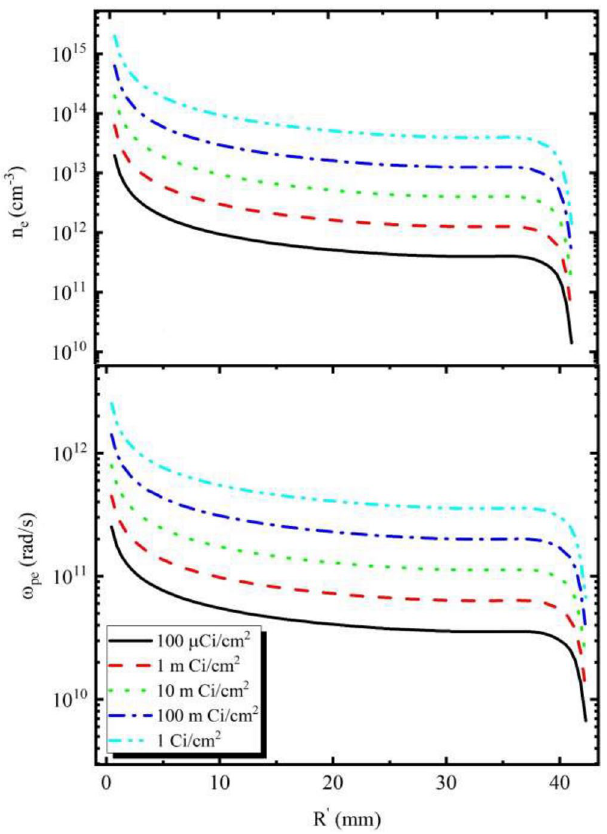
Figure 3. Electron density and plasma frequency of surroundings around the cylinder.